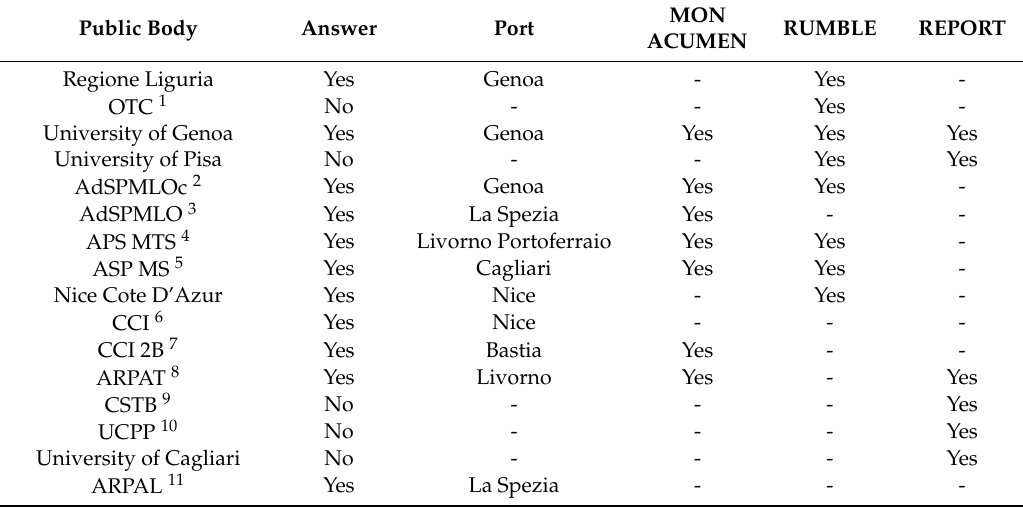
Table 2. The main bodies involved in the campaign and the projects in which they participate. Public